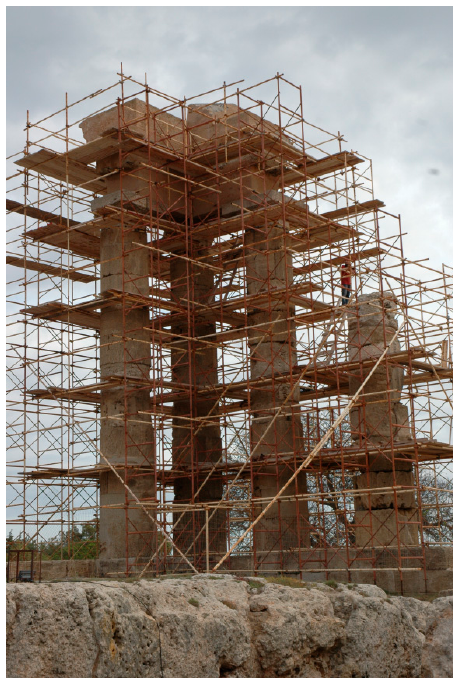
Figure 28. The Temple of Pythian Apollo of Rhodes Today (2017).